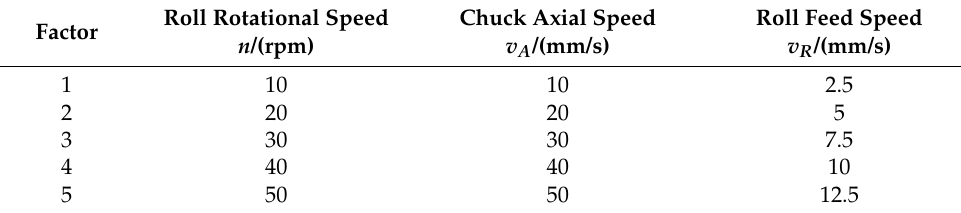
Table 1. Parameters setting of FEM single-factor experiment.